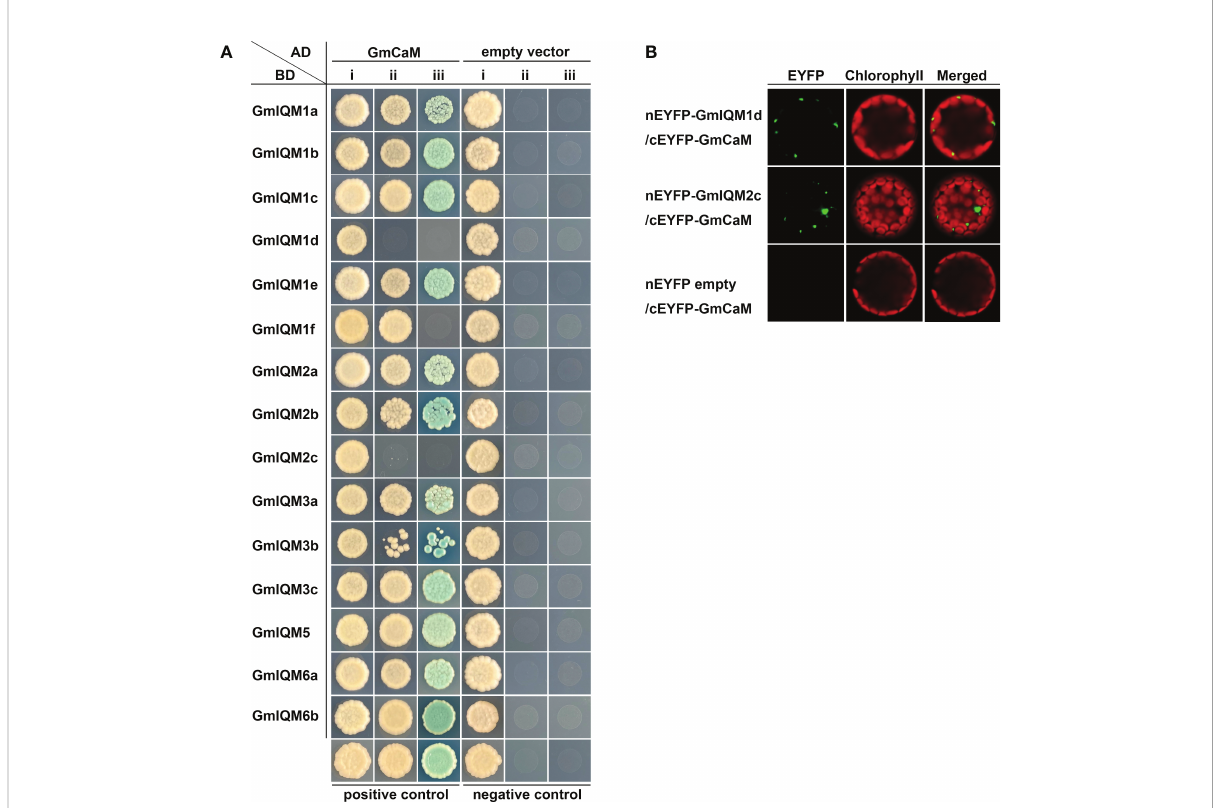
FIGURE 1 Interaction Between Gmiqms And Gmcam. (A) GmIQMs interact with GmCaM in yeast cells. pGADT7-GmCaM and pGBKT7-GmIQMs were co- transformed into AH109 yeast cells, which were grown on SD/-Trp-Leu (i), SD/-Trp-Leu-His (ii) and SD/-Trp-Leu-His-Ade containing 20 m g/ml x- a -gal (iii) for 3 days. Co-transformation with the AD empty vector and BD-empty vector served as negative controls. AD-AtCAT2 and BD- AtIQM1 were used as positive controls. (B) BiFC assays to detect the interaction between GmIQM1d/GmIQM2c and GmCaM. nEYFP-GmIQM1d/ GmIQM2c and cEYFP-GmCaM plasmids were co-transformed into protoplasts isolated from the leaves of 4-week-old Col-0 plants. After 16 h of incubation, the EYFP signals were observed using a laser confocal microscope. nEYFP-empty vector and cEYFP-GmCaM were employed as negative